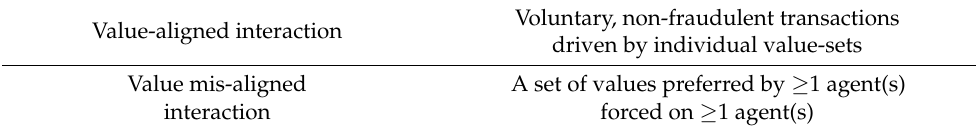
Table 1. Fundamental dichotomy of autonomous agent interaction in terms of